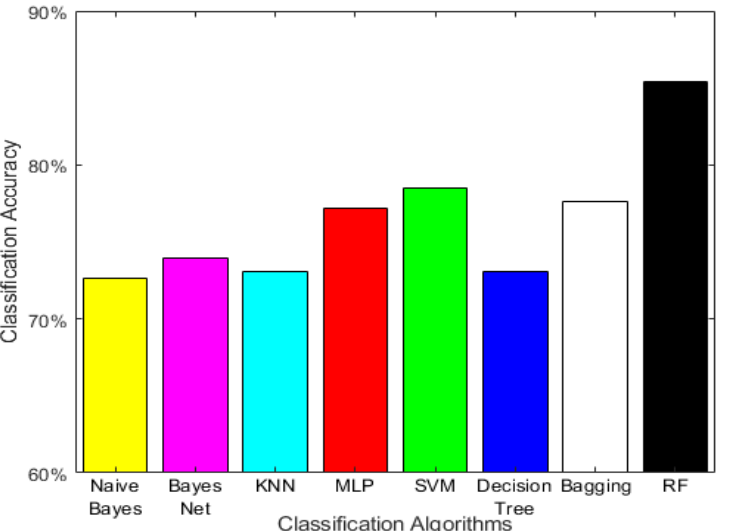
Figure 3. Comparison results bar plot. This bar plot visualizes the test set’s experimental results between the proposed method and seven other popular classification algorithms. It can be seen that the RF method used in RF-BCI produced significantly better results since it was 6.85% better than the 2nd best algorithm (SVM).